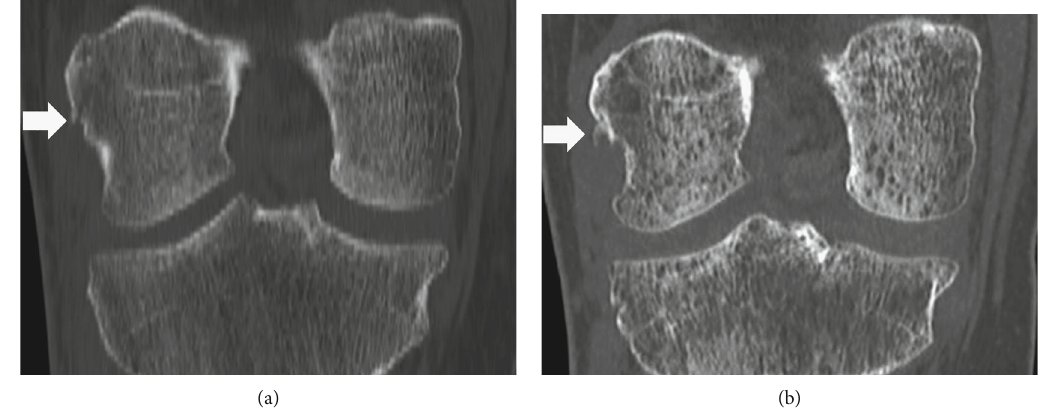
Figure 5: Patient case 2. Frontal plane CT assessment. (a) At day 1, showing the avulsed bony fragment of the femoral insertion of the LCL (white arrow). (b) At 4.5 months, showing bone union with mild calci fi cation of the femoral attachment of the LCL (white